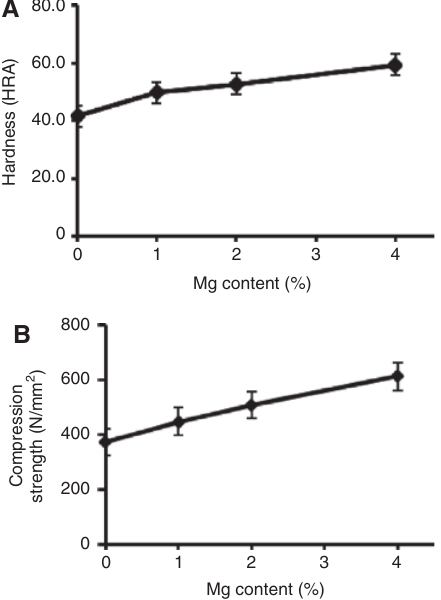
Figure 3: Hardness (A) and compression (B) results of the investi- gated samples.